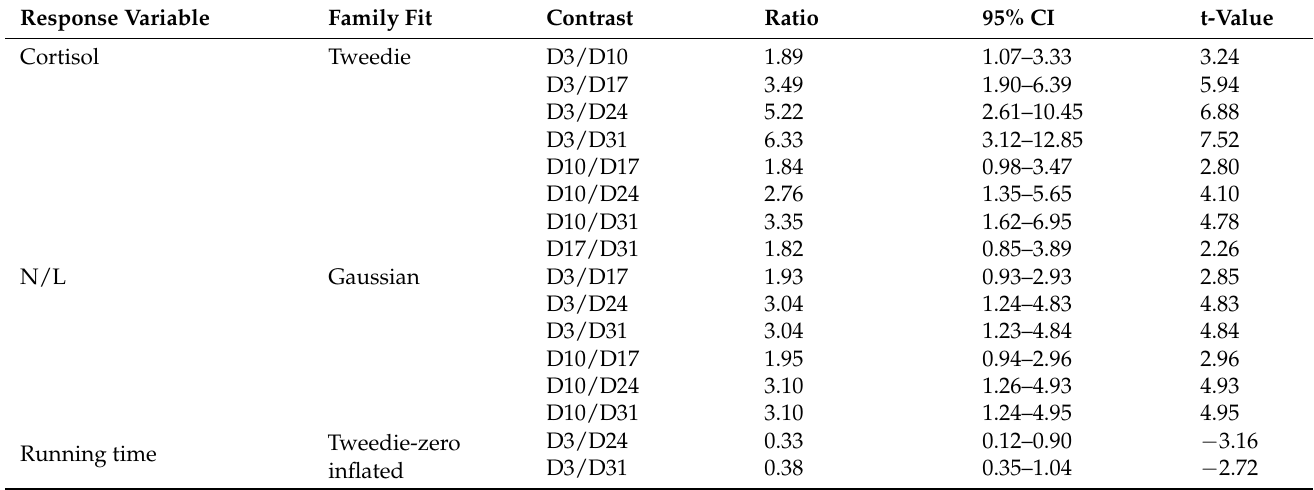
Table 2. Significant pairwise comparisons ( p < 0.05) after pairwise contrasts using a Bonferroni-Holm post hoc correction. Estimated means are in Figure 2. Data are based on 21 dairy calves observed every week from the 3rd to 31st day of age (D3, D10, D17, D24, D31) at CiRAA (Centro di Ricerche Agro-Ambientali “E. Avanzi”—University of